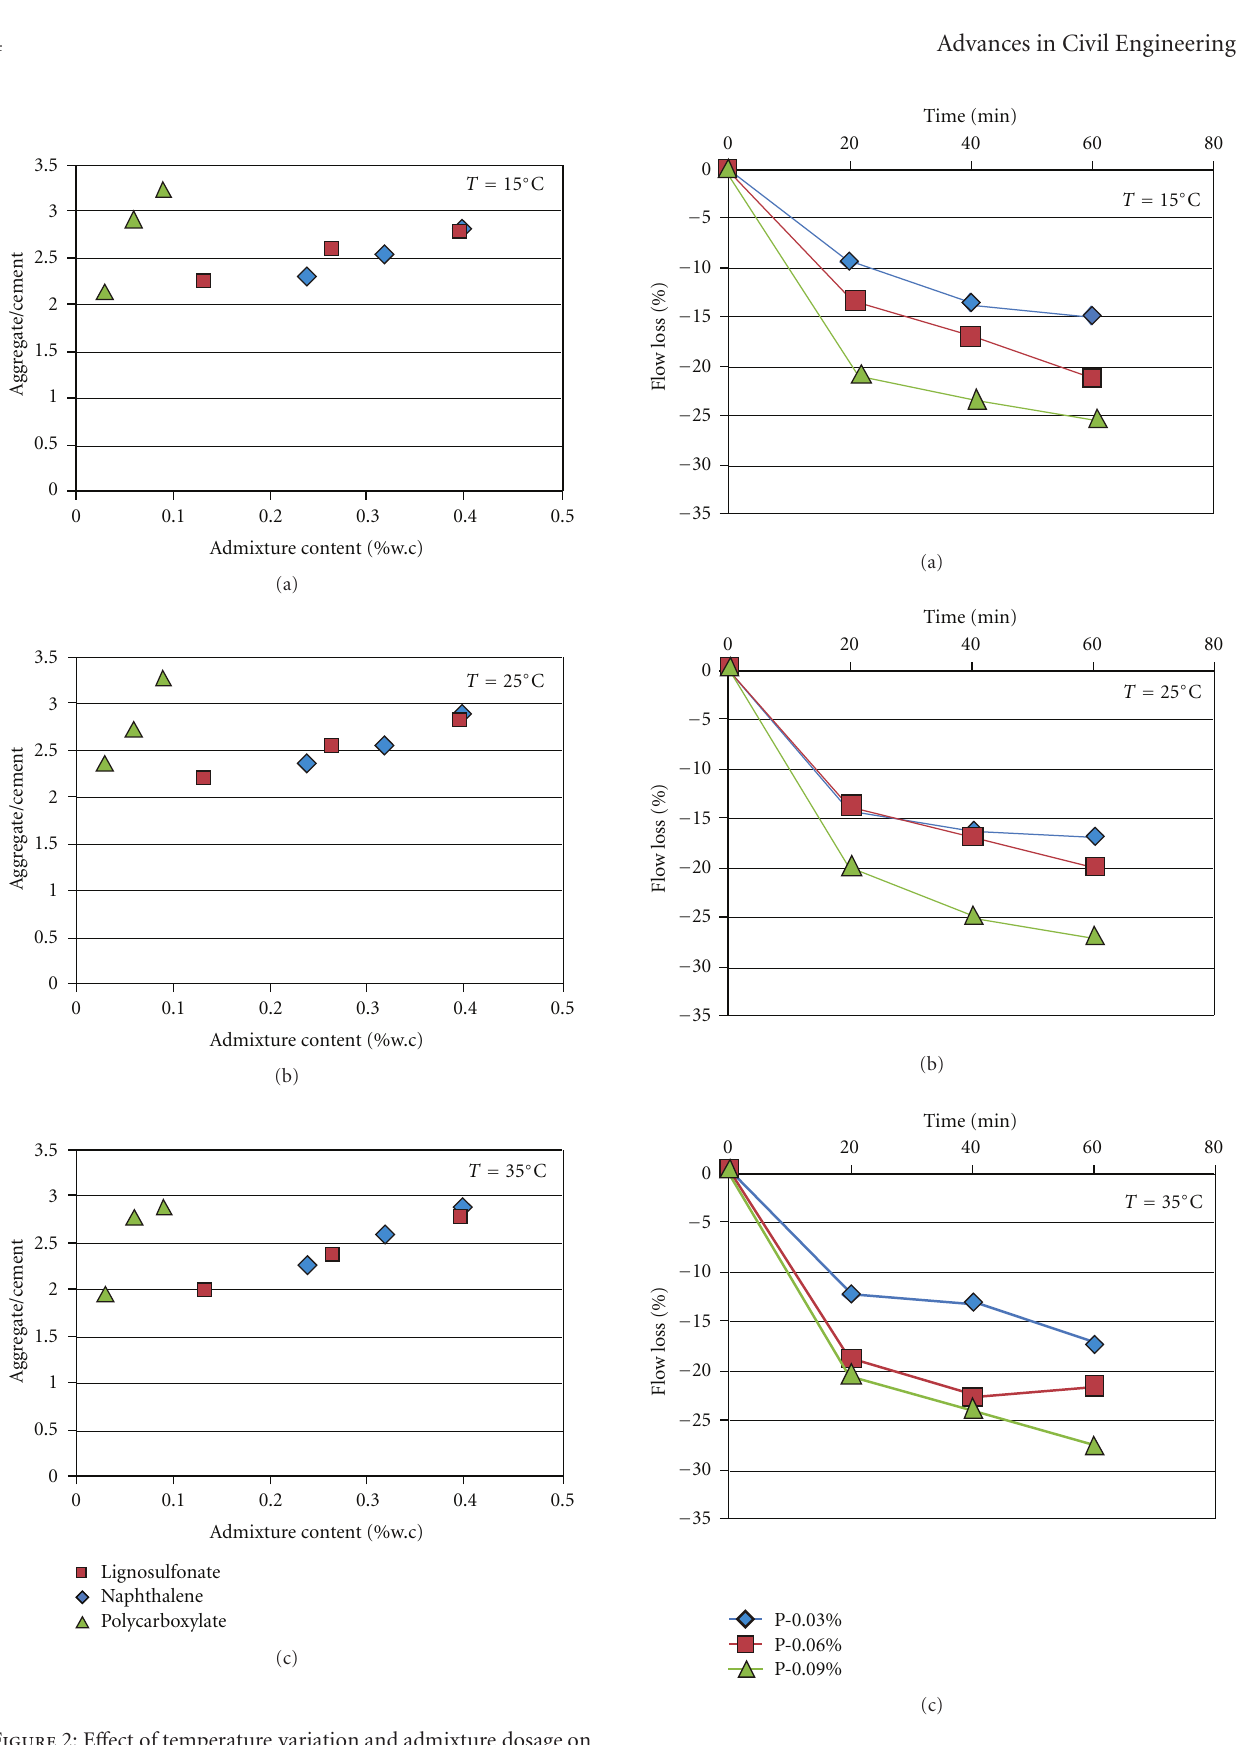
Figure 2: E ff ect of temperature variation and admixture dosage on initial consistency. Figure 3: E ff ect ofadmixture dosage